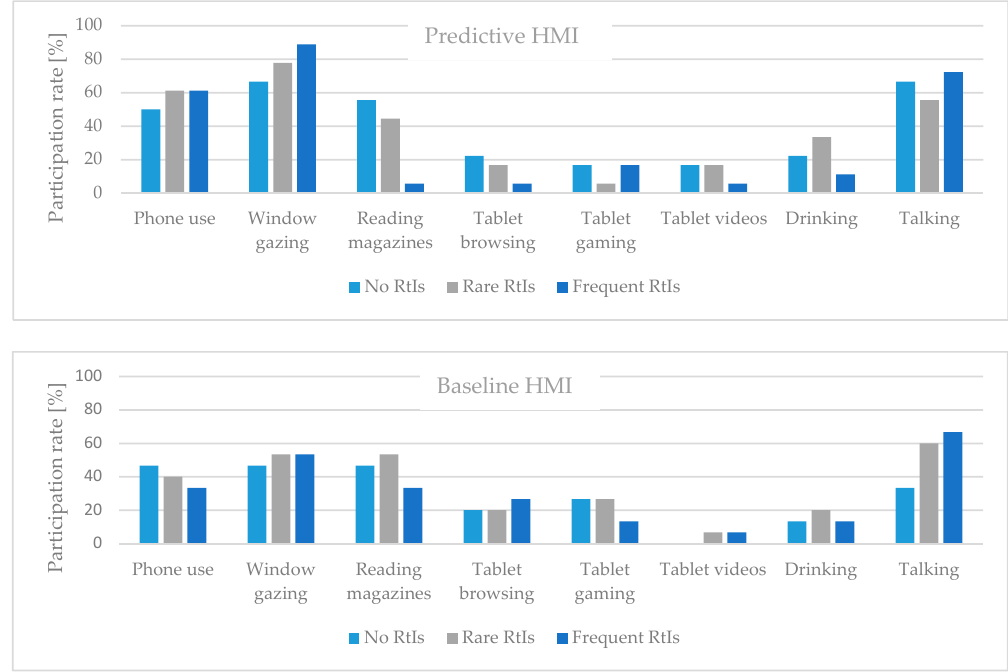
Figure 7. Participation rates for predictive HMI and baseline HMI group, per RtI condition.